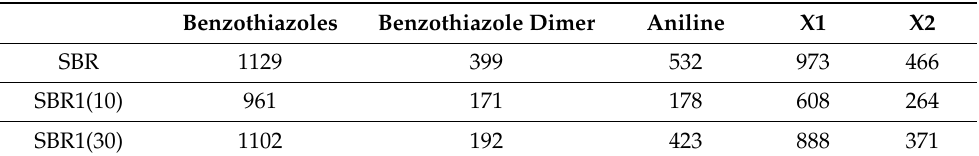
Table 9. Comparison of the intensity of VOC signals released during the vulcanization process from the tested rubber mixtures.